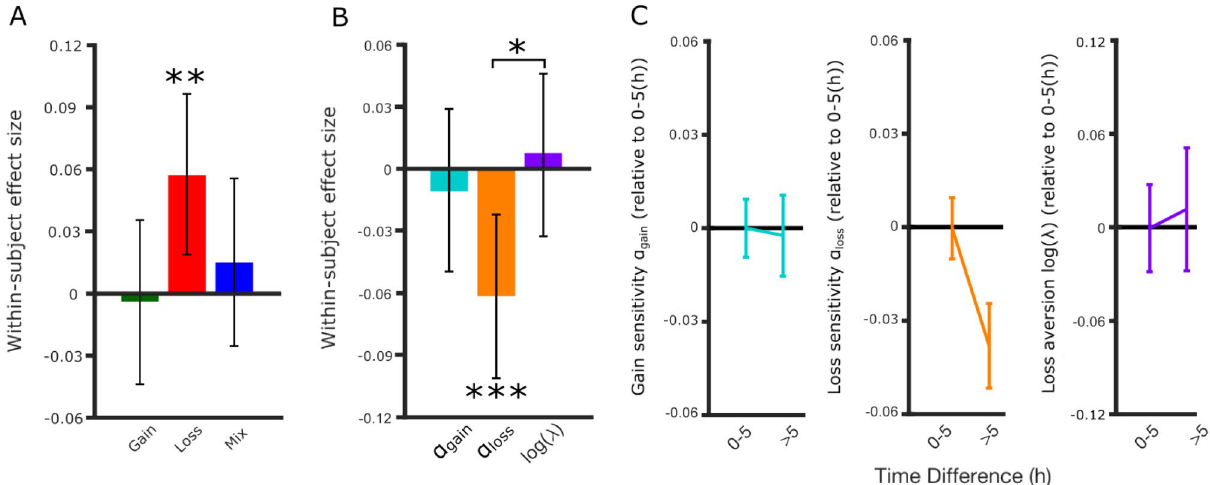
Figure 2. Loss sensitivity decreases with time of day in individuals. ( A ) We identified individuals (N = 2599) who completed the risky decision task on two different days between 08:00 and 22:00. Risk taking in loss trials increased with time of day within individuals. ( B ) Loss sensitivity (α loss ), but not gain sensitivity (α gain ) or loss aversion (log(λ)), decreased with time of day in this within-subject sample. Error bars represent bootstrapped 95% confidence intervals [* p < 0.05, ** p < 0.01, *** p < 0.005]. ( C ) Loss sensitivity was lower for later plays in within-subject analysis. Error bars represent bootstrapped 95% confidence intervals. Data binned on differences less (N = 1,643) or more than 5 h (N = 956) are shown for illustration purposes. [* p < 0.05, ** p < 0.01, *** p <